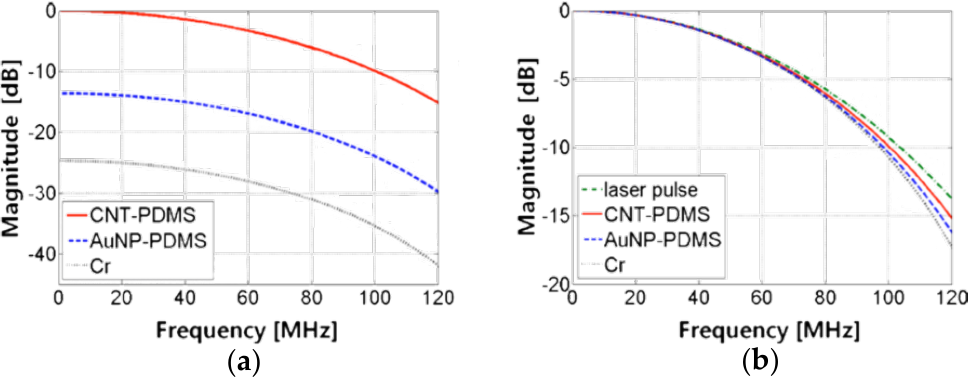
Figure 10. Comparison between the performance of CNT–PDMS composite, gold nanoparticles- PDMS composite, and chromium film. ( a ) Frequency spectra normalized to the DC value of the CNT–PDMS composite. ( b ) Frequency spectra normalized to each DC value compared to that of the laser that was employed. Reproduced with permission from [93].